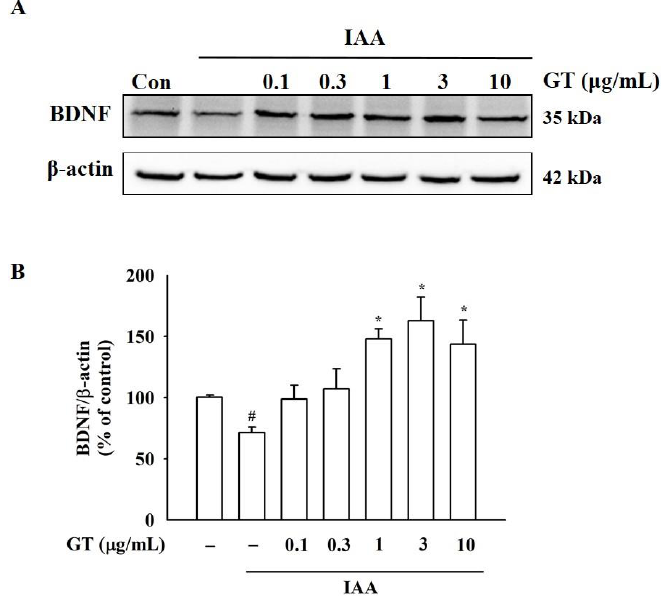
Figure 3. Changes in brain-derived neurotrophic factor (BDNF) protein expression induced by gintonin in IAA-treated HT22 cells. ( A ) BDNF expression levels were detected by Western blot analysis using β -actin as a loading control. HT22 cells were treated with 5 µ M IAA for 2 h, followed by gintonin treatment with different concentrations (0.1–10 µ g/mL) for 24 h in the absence or presence of IAA. ( B ) BDNF/ β -actin ratio at each dose. The data are represented as the mean ± standard error of the mean (SEM; n = 4). # p < 0.01 compared to the control group; * p < 0.01 compared to the IAA-treated